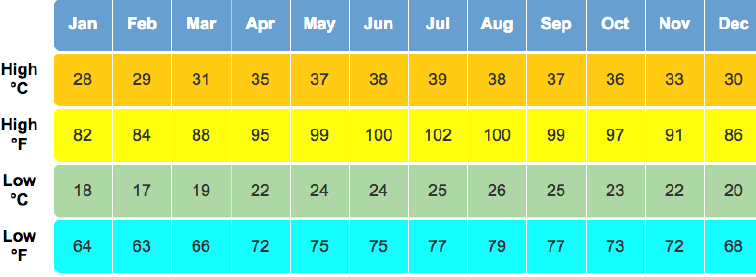
Figure 1. Climate Data of Jeddah Source: Jeddah Regional Climate Center,